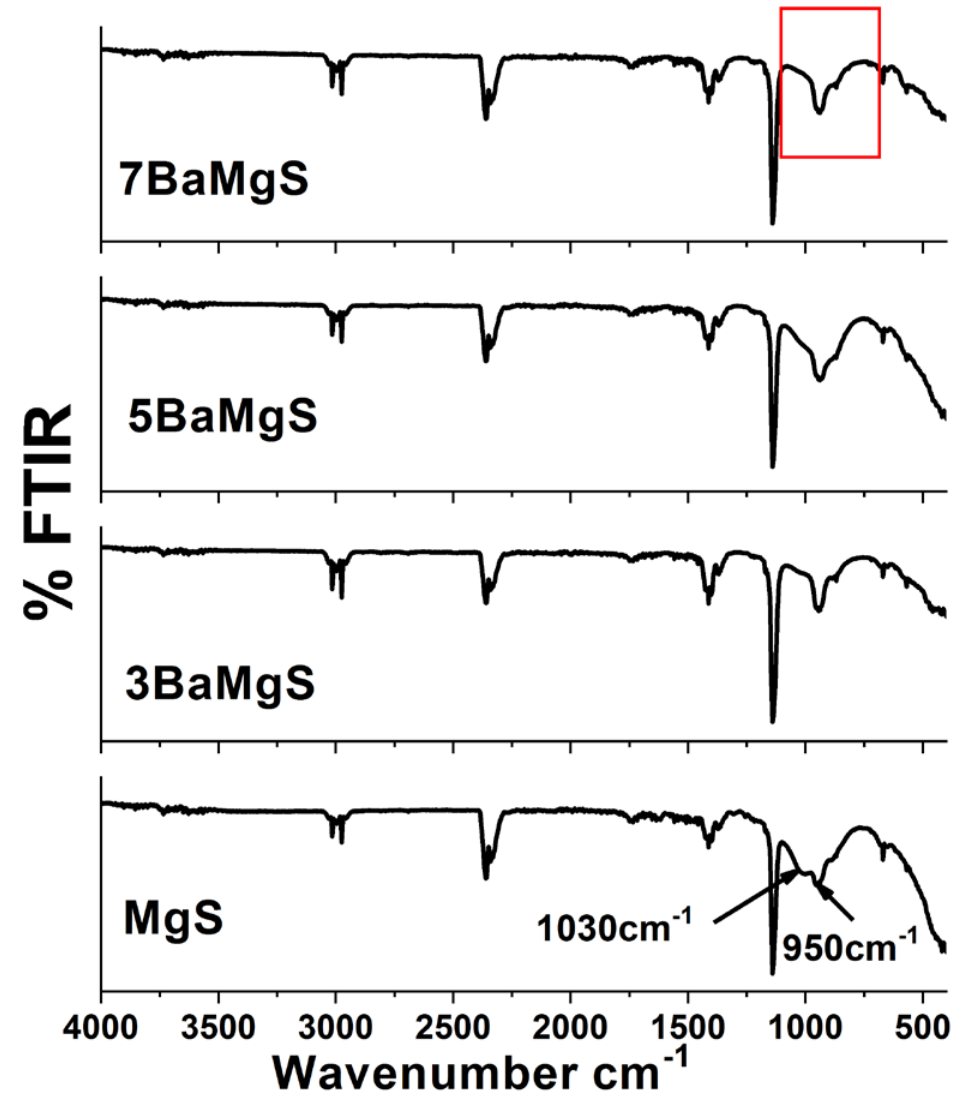
Figure 3. FTIR spectra of the prepared MgS samples before and after doping with Barium.